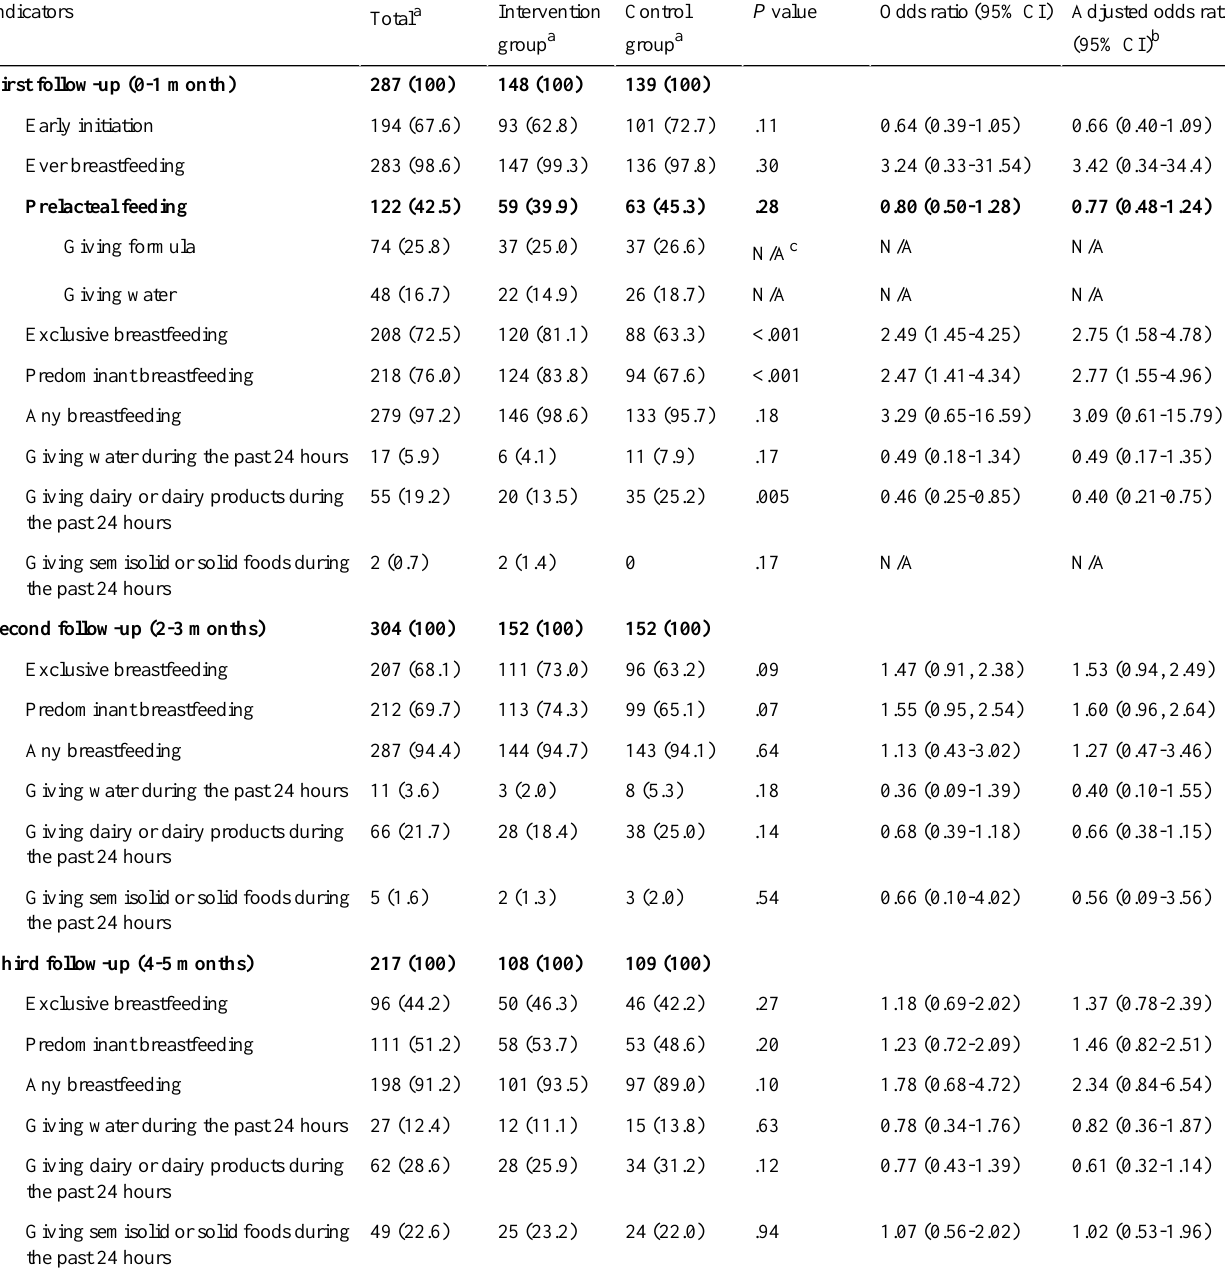
Table 2. Comparison of infant feeding